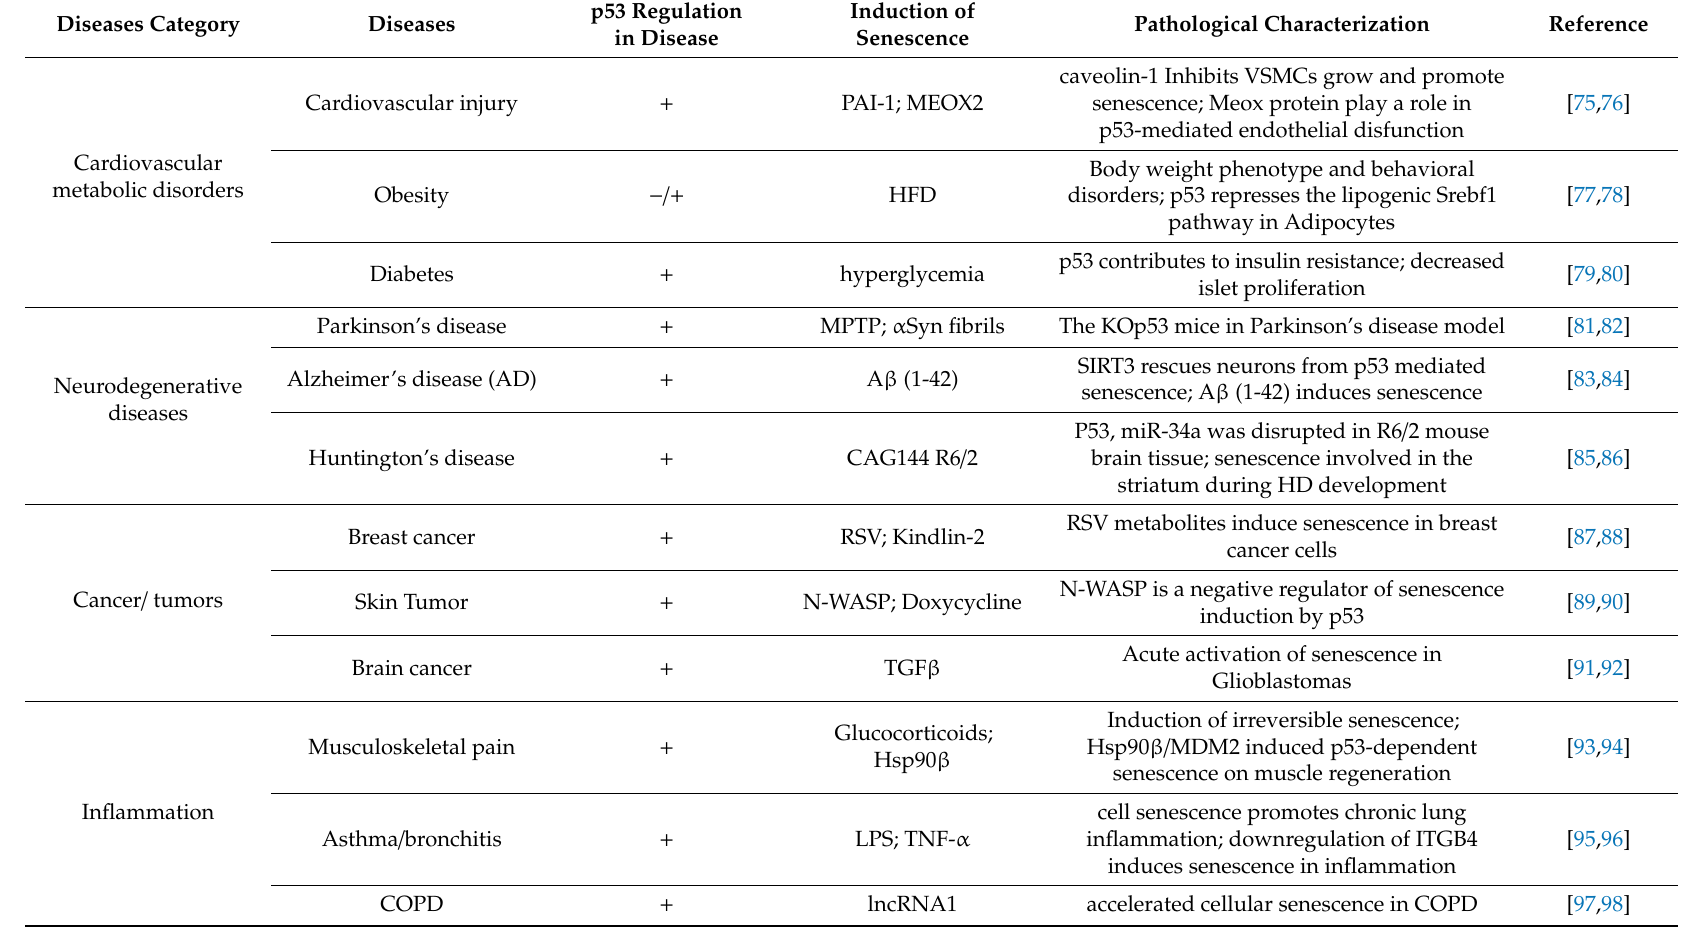
Table 2. The mechanism summary of p53-mediated cellular senescence in di ff erent